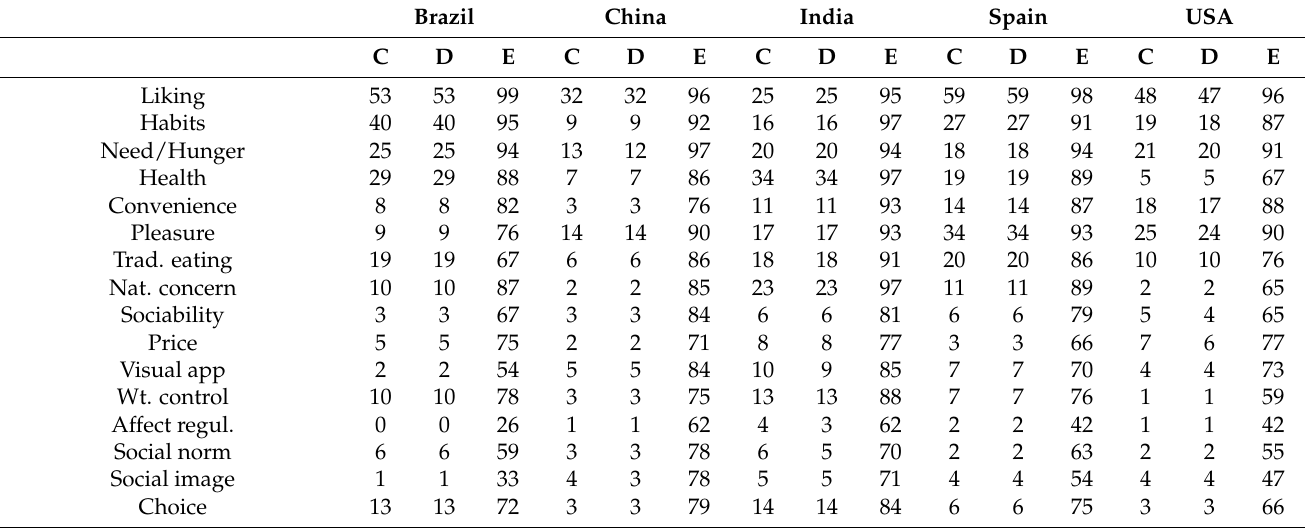
Table A1. Percentage of “apply” responses for CATA, RATA, and RATING for all five countries for the respective protein- rich foods.